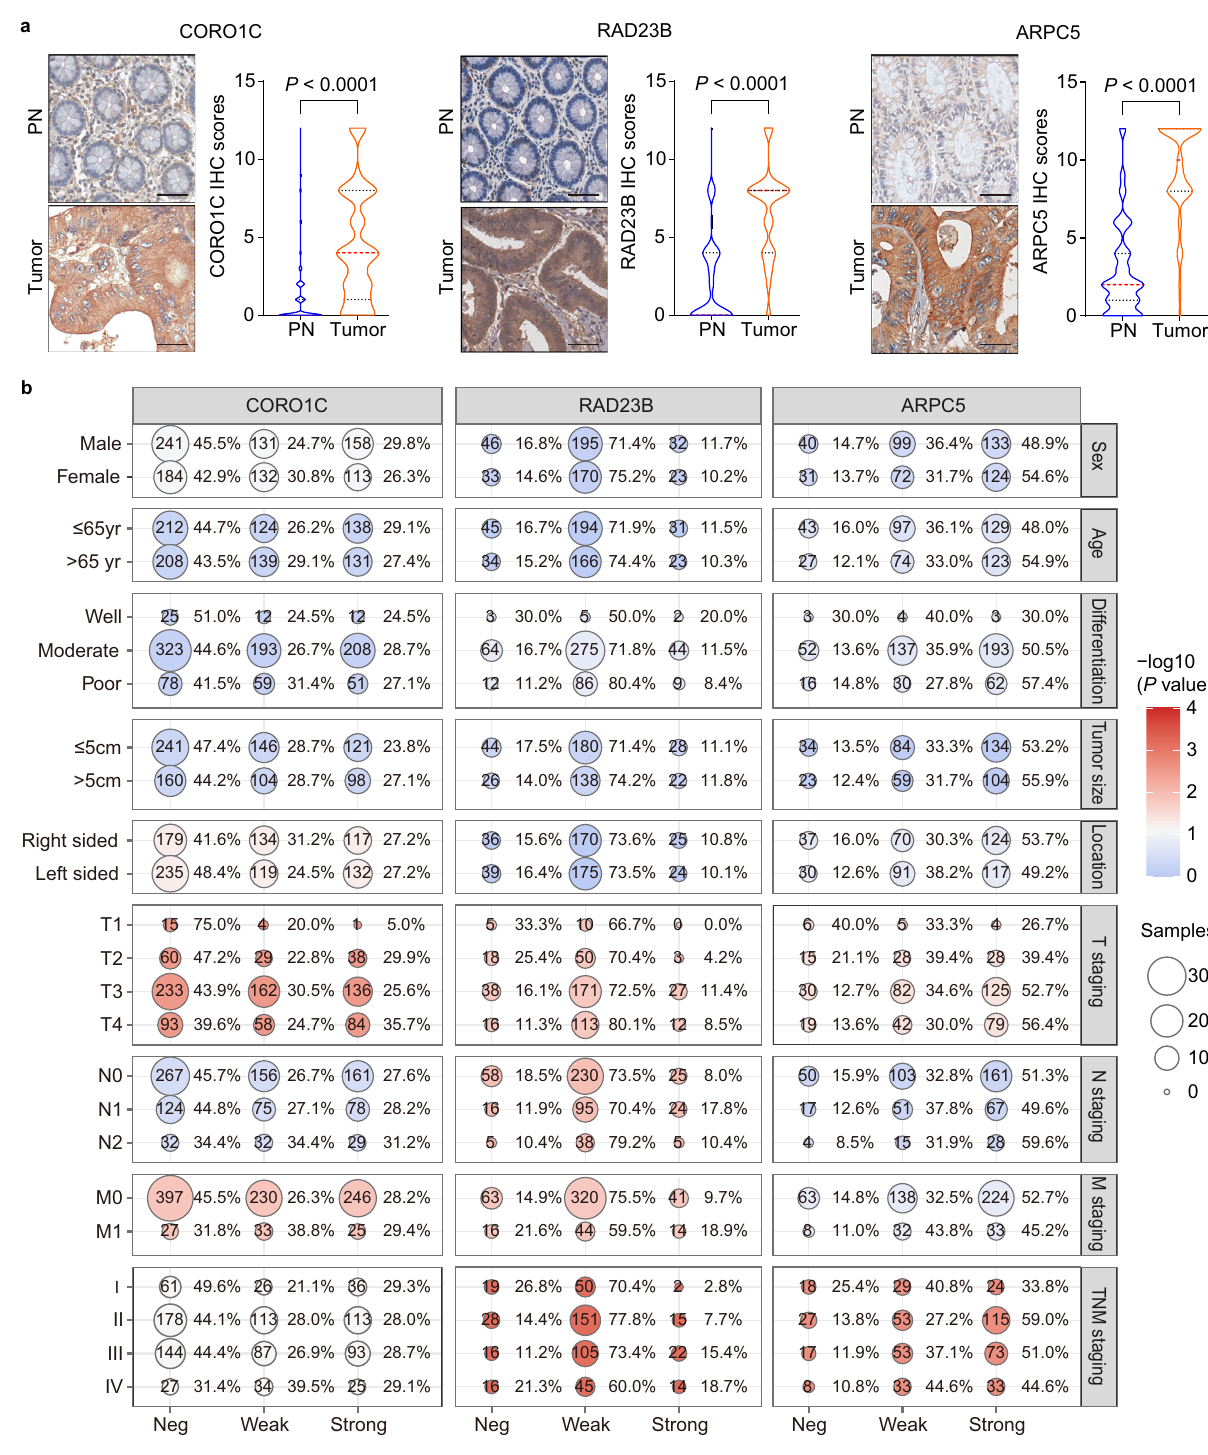
Fig. 5 Immunohistochemical staining of three diagnostic biomarkers in tissues and their clinical signi fi cance. a Representative immunohistochemistry images and score distribution of CORO1C, RAD23B, and ARPC5 expression in paracarcinoma normal tissues (PN) and CRC tumors (tumor). The median and quartile values in each group of individuals are shown as thick red dash lines and thin black dotted lines, respectively. Scale bar: 50 μ m. The statistical analysis was performed by two-sided Mann – Whitney rank test. b The balloon plot for the clinical signi fi cance of CORO1C, RAD23B, and ARPC5 in colon adenocarcinoma patients with distinct staining intensities. The number in the circle is the sample size, and the percentage next to the circle is the corresponding percentage. Chi-square test was used for calculating the two-sided P values. Neg negative, Weak weak expression, Str. strong expression. The source data are provided in Source